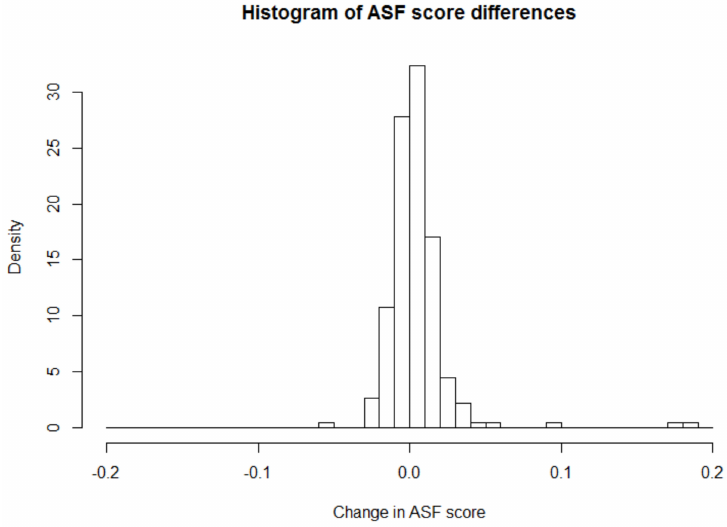
Figure 3. Plot showing unweighted histogram of ASF score